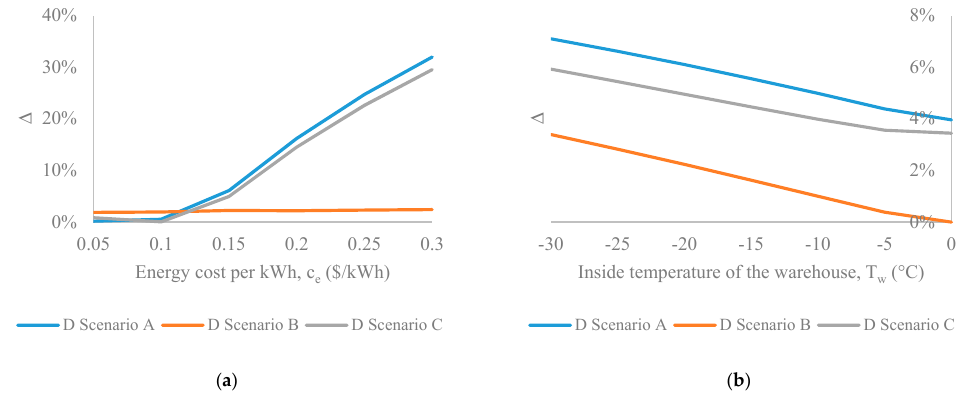
Figure 5. The behavior of the percentage error in total cost from not considering the filling level and / or temperature adjustment, ∆ , for changes in the values of ( a ) the unit energy cost, c e and ( b ) the temperature set inside the warehouse, T w